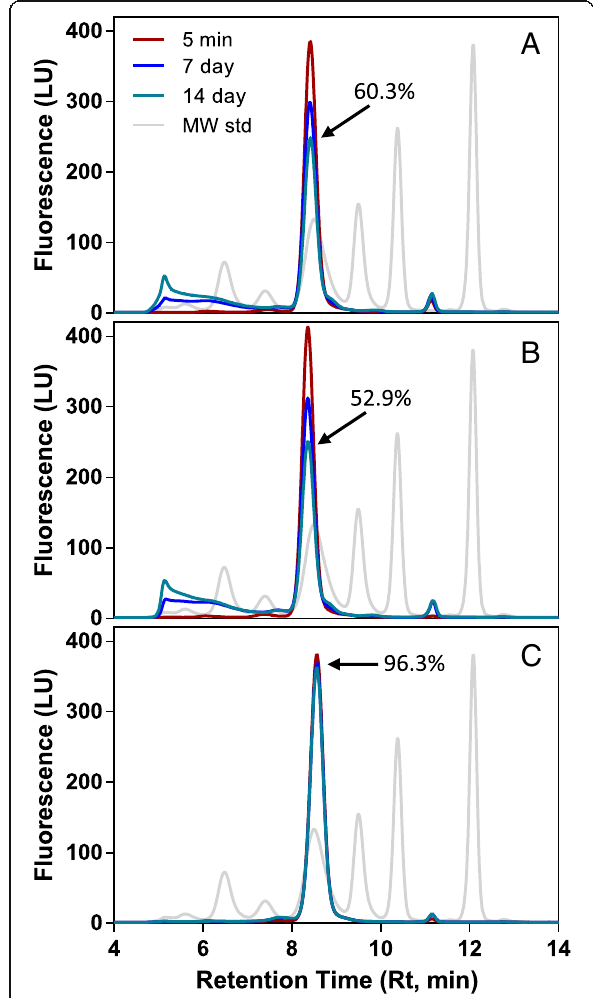
Fig. 5 In vitro stability of unconjugated anti-CD74 ( a ), anti-CD74- Phos-Bud ( b ), and isotype matched control antibody, mAb-C ( c ). Shown are the fluorescence SEC-HPLC profiles of DyLight 650- labeled antibodies in undiluted C57BL/6 J mouse plasma following incubation at 37 °C for 5 min, 7 days, and 14 days. The plasma samples were run on a BioSep-SEC-S3000 column at 1 mL/min elution rate with PBS as a mobile phase for 15 min. Black arrows indicate the percent of intact, monomeric IgG at day 14